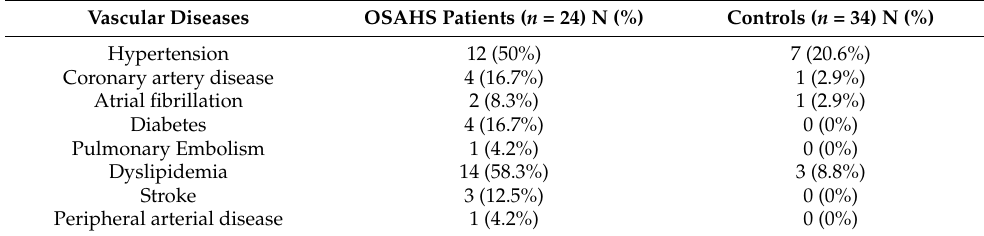
Table 2. Vascular comorbidity of OSAHS patients and controls.